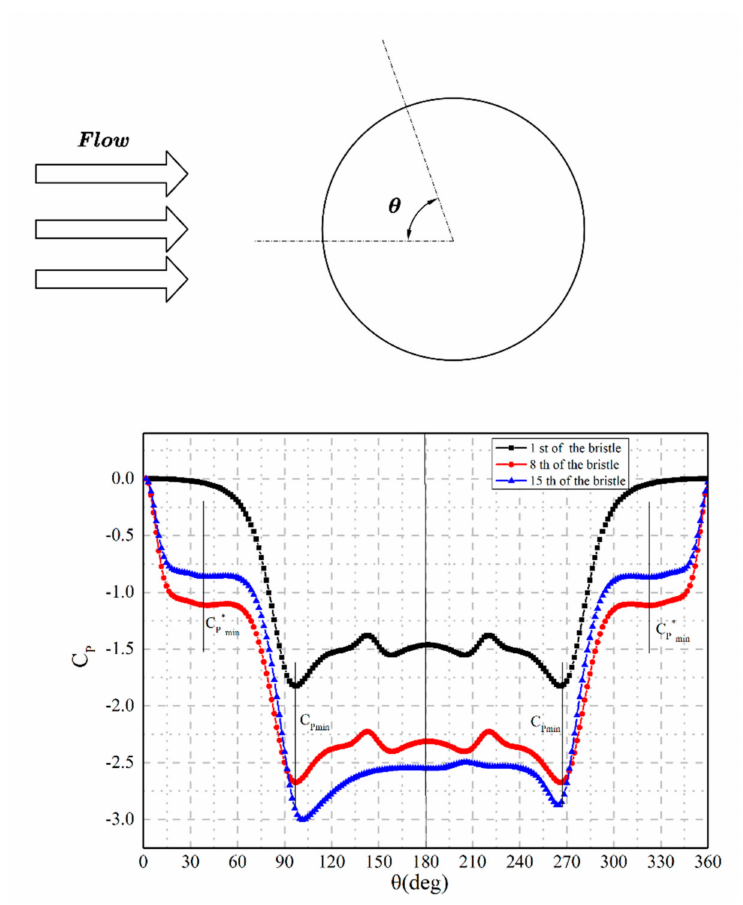
Figure 10. The distribution of C P on the bristle